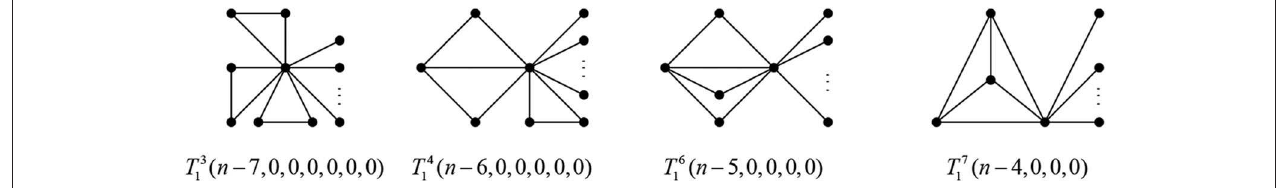
FIGURE 5 | The extremal graphs.